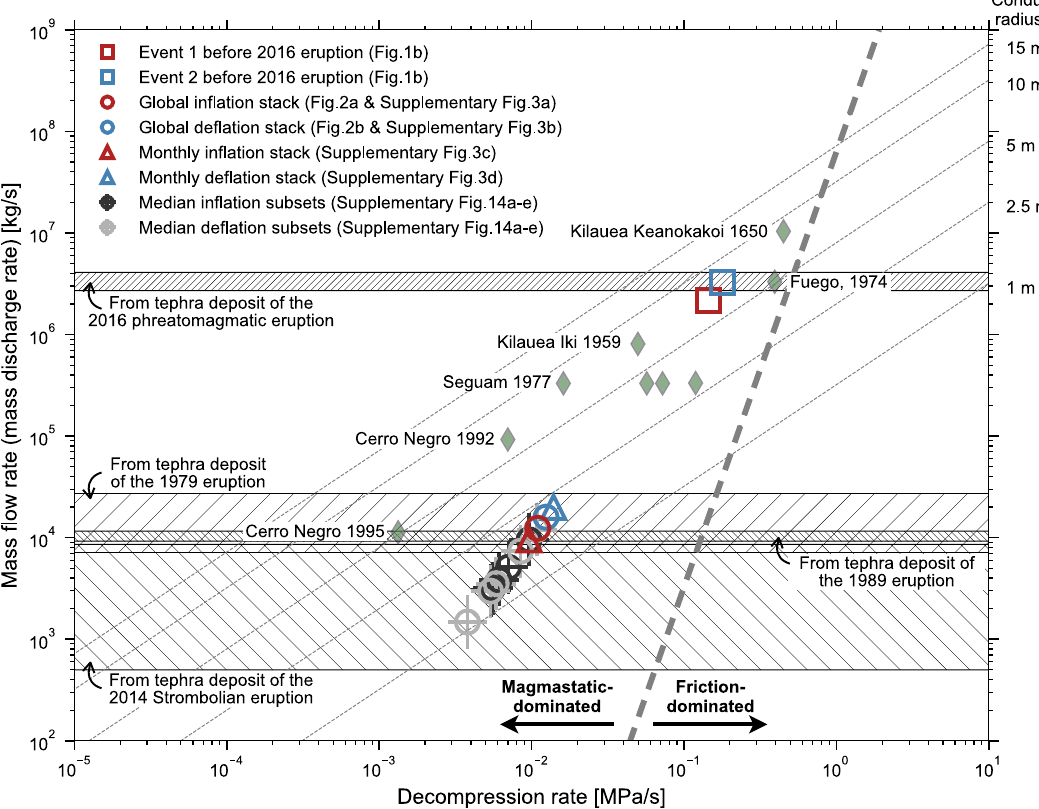
Fig. 7 Comparisons of the mass fl ow rate and decompression rate from selected basaltic volcanoes and Aso: petrology and seismology. Open circles and triangles mark the volume estimates from waveform stacks of in fl ation and de fl ation events before the 2014 and 2016 eruptions (see details in the main text). Target crosses mark the median volume estimates from the fi ve subsets (Supplementary Fig. 14a – e). Green diamonds mark previous compilations in selected basaltic volcanoes 8 , where the decompression rates are estimated from water diffusion in olivine or embayment studies and the mass discharge rates are estimated from volcanic outputs or plume heights, respectively. Contour lines display theoretical estimate of decompression rate and mass fl ow rate against fi xed conduit radius (see equation 4 in Barth et al. 8 ). Hatched areas show the mass discharge rate of the 1979, 1989, 2014, and 2016 eruptions in Aso volcano (see details in the main text). Dashed line indicates the boundary of magmastatic-dominated and friction-dominated decompression after Barth et al. 8